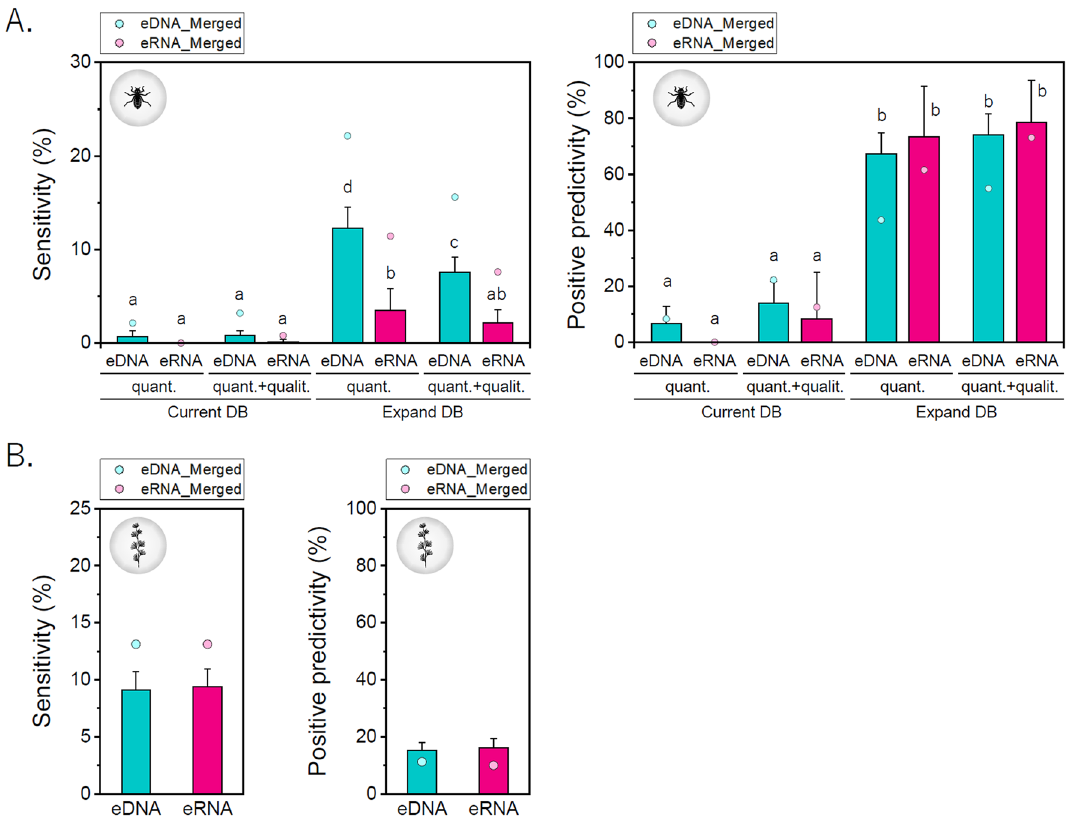
Figure 1. Performance of eDNA/eRNA metabarcoding analysis in ecological surveys of arthropods and algae. Sensitivity and positive predictivity of metabarcoding analysis for ( A ) arthropods and ( B ) algae. eDNA/eRNA: eDNA/eRNA metabarcoding analysis, quant.: quantitative analysis, qualit.: qualitative analysis. Dots indicate the performance when individual data are merged. The values represent the mean + standard deviation (SD). Different letters indicate significant differences (Tukey–Kramer test). The values represent the mean + standard deviation (SD). Arcsine transformation did not change the and qualitative data (no significant differences were found). Similar results were confirmed for the metabarcod- ing of arthropod ecological surveys using the MLIT database (Supplementary Fig. S1). Thus, in this study, we mainly analyzed the conditions with high sensitivity (using quantitative TFS data obtained in the present study and an expanded database of metabarcoding analysis) for arthropods. When comparing eDNA and eRNA, the sensitivity of eDNA was significantly higher than that of eRNA in the expanded database. In contrast, the positive predictivity of eRNA was higher than that of eDNA, although no significant difference was found. When individual datasets were merged, sensitivity increased, and positive predictivity decreased. The order of the performance of eDNA and eRNA did not change. However, the percentage increase in sensitivity with the merged data was higher for eRNA (eDNA: 12.3–22.1% [× 1.79], eRNA: 3.5–11.4% [× 3.25]). In contrast, the percentage decrease in positive predictivity was higher for eDNA (eDNA: 67.4–43.7% [× 0.83], eRNA: 73.4–61.5% [× 0.64]). This indicates that eRNA can easily increase sensitivity, and eDNA may be prone to generating false positives on using merged data. The performance of each taxon was also evaluated, focusing on the EPTOD ( Table 2 ). Plecoptera was not detected in eDNA or eRNA metabarcoding. In terms of sensitivity, Ephemeroptera had the highest average score for eDNA and Diptera had the greatest score for eRNA. Odonata had the highest merged score for both eDNA and eRNA. In terms of positive predictivity, the average and merged scores were the highest for Ephemeroptera in eDNA and Trichoptera in eRNA. In algae, the sensitivity was mostly equivalent. The average score was slightly higher for eRNA (eDNA 9.1%, eRNA 9.4%), and the merged score was equal (no significant difference). Positive predictivities were also similar. The average score was higher for eRNA, whereas the merged score was higher for eDNA. However, no significant differences were found (Fig. 1B). Differences in the species detected using eDNA/eRNA vs. TFS analyses. Venn diagrams illustrate the differences in species detected between the eDNA/eRNA metabarcoding analysis and TFS under multiple analytical conditions (Fig. 2). For the arthropods, eDNA and eRNA analyses detected 71 and 26 species, respec- tively. The TFS detected 140 species at two sampling points (Nakagawa-oohashi and Shin-nakabashi). The lower